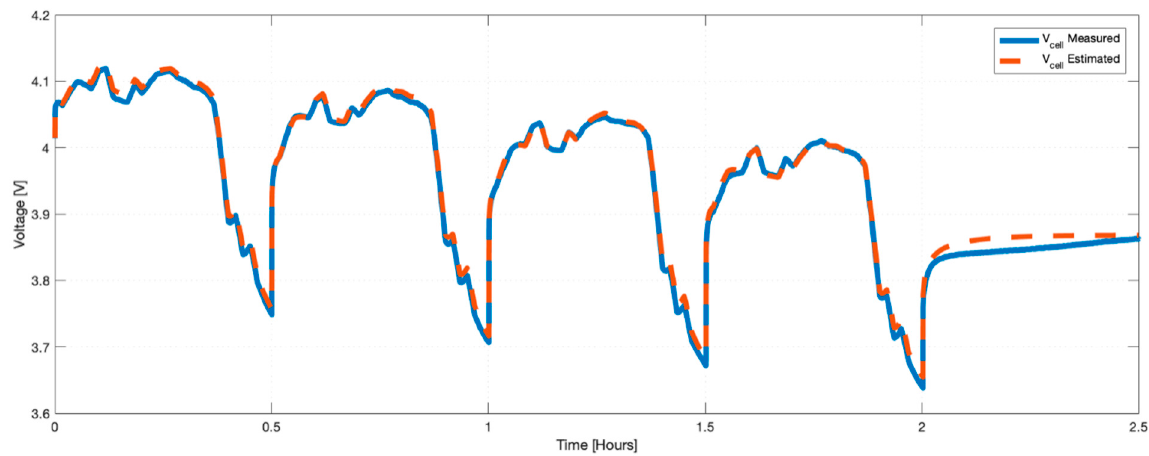
Figure 9. Cell I: Voltage measured versus estimated for one cycle (31 < SOC< 42).